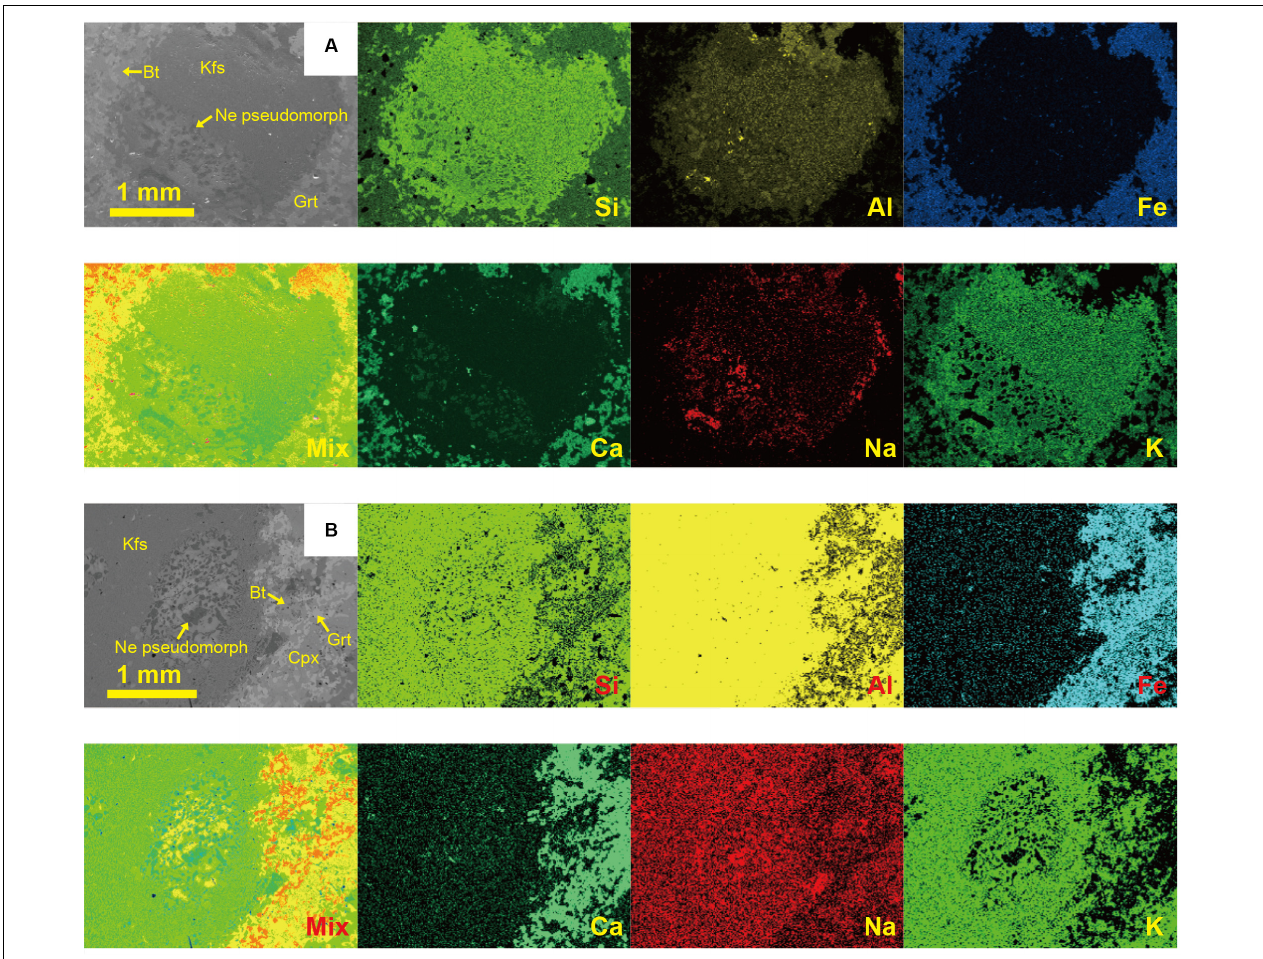
FIGURE 8 | Secondary electrons and scanning electron microscope (SEM) images of the pseudoleucite clinopyroxenite. (A) A pseudoleucite ( Figure 4F ) surrounded by the matrix. (B) The boundary between pseudoleucite and